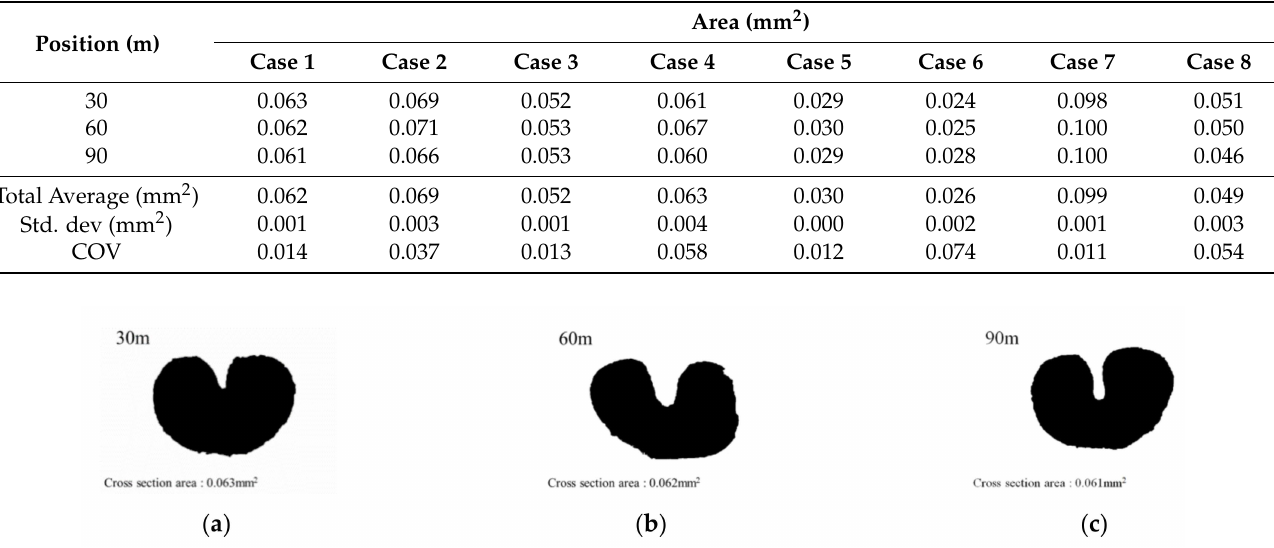
Figure 8. Cross section area of case 1 ( x 1 : x 2 : x 3 : x 4 = 40:60:120:200). ( a ) Specimen 30 m; ( b ) Specimen 60 m; ( c ) Specimen 90 m.